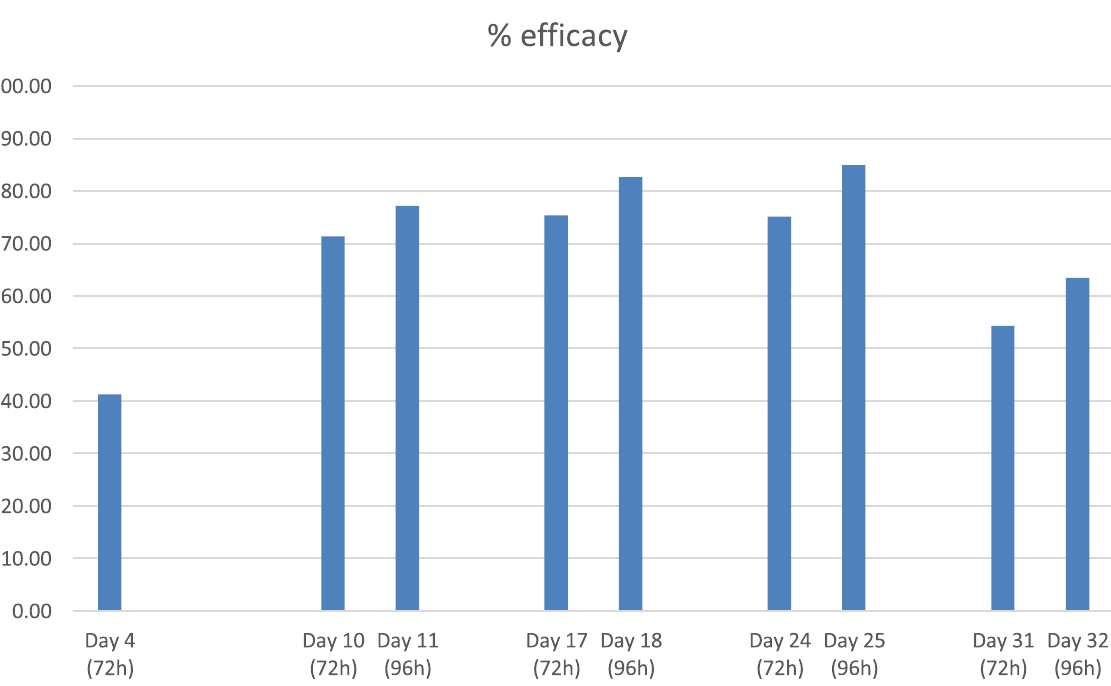
Figure 3. % NexGard ef fi cacy against bedbug feeding on treated